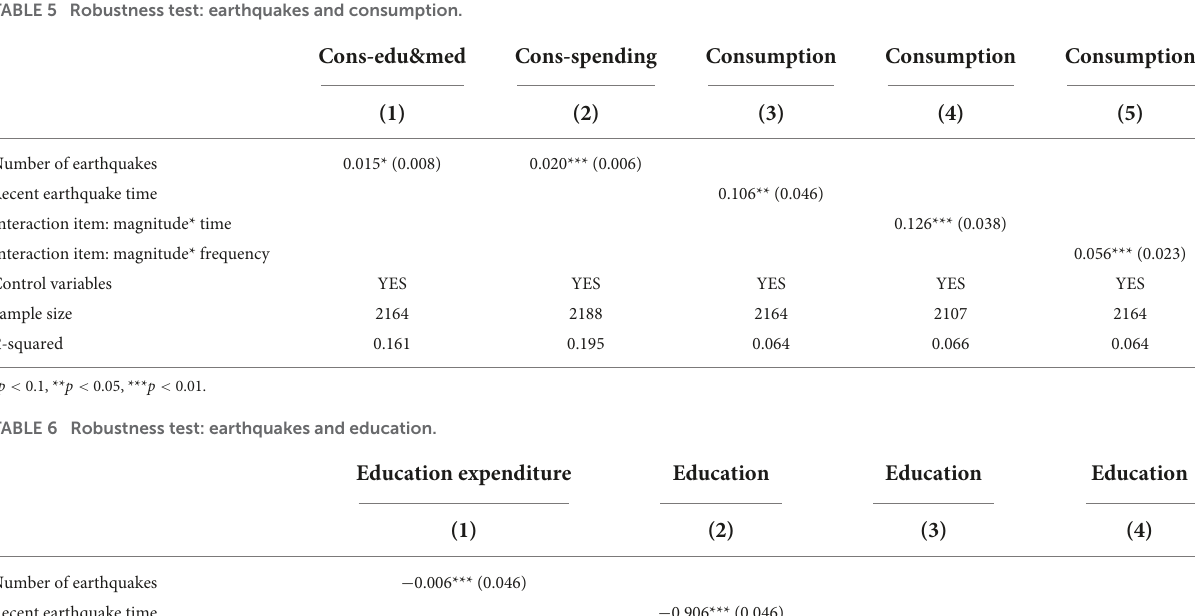
TABLE 5 Robustness test: earthquakes and consumption.